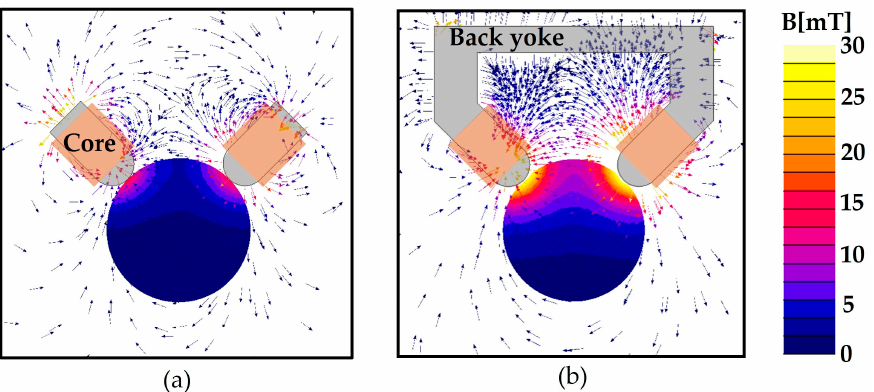
Figure 3. Magnetic flux density distribution around electromagnets. ( a ) Two electromagnets with the core; ( b ) Two electromagnets with the core and back yoke.